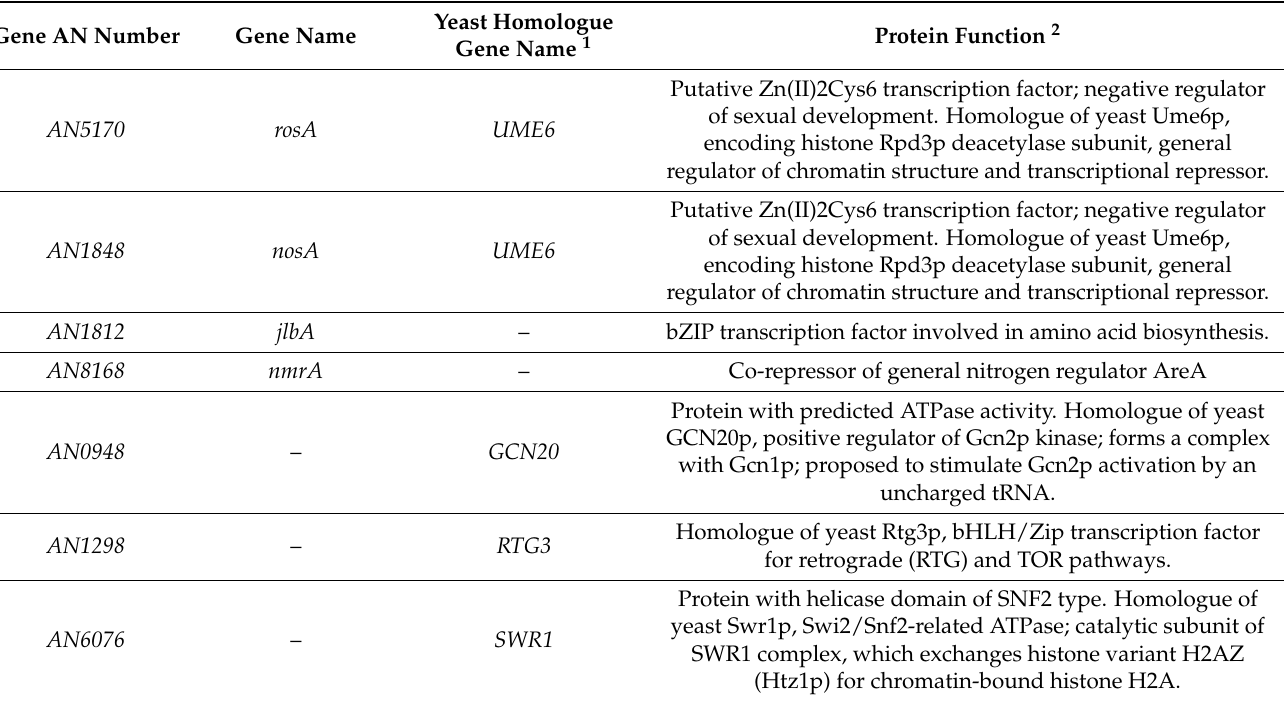
Table 1. Differentially expressed genes coding for regulatory proteins selected for RT-qPCR